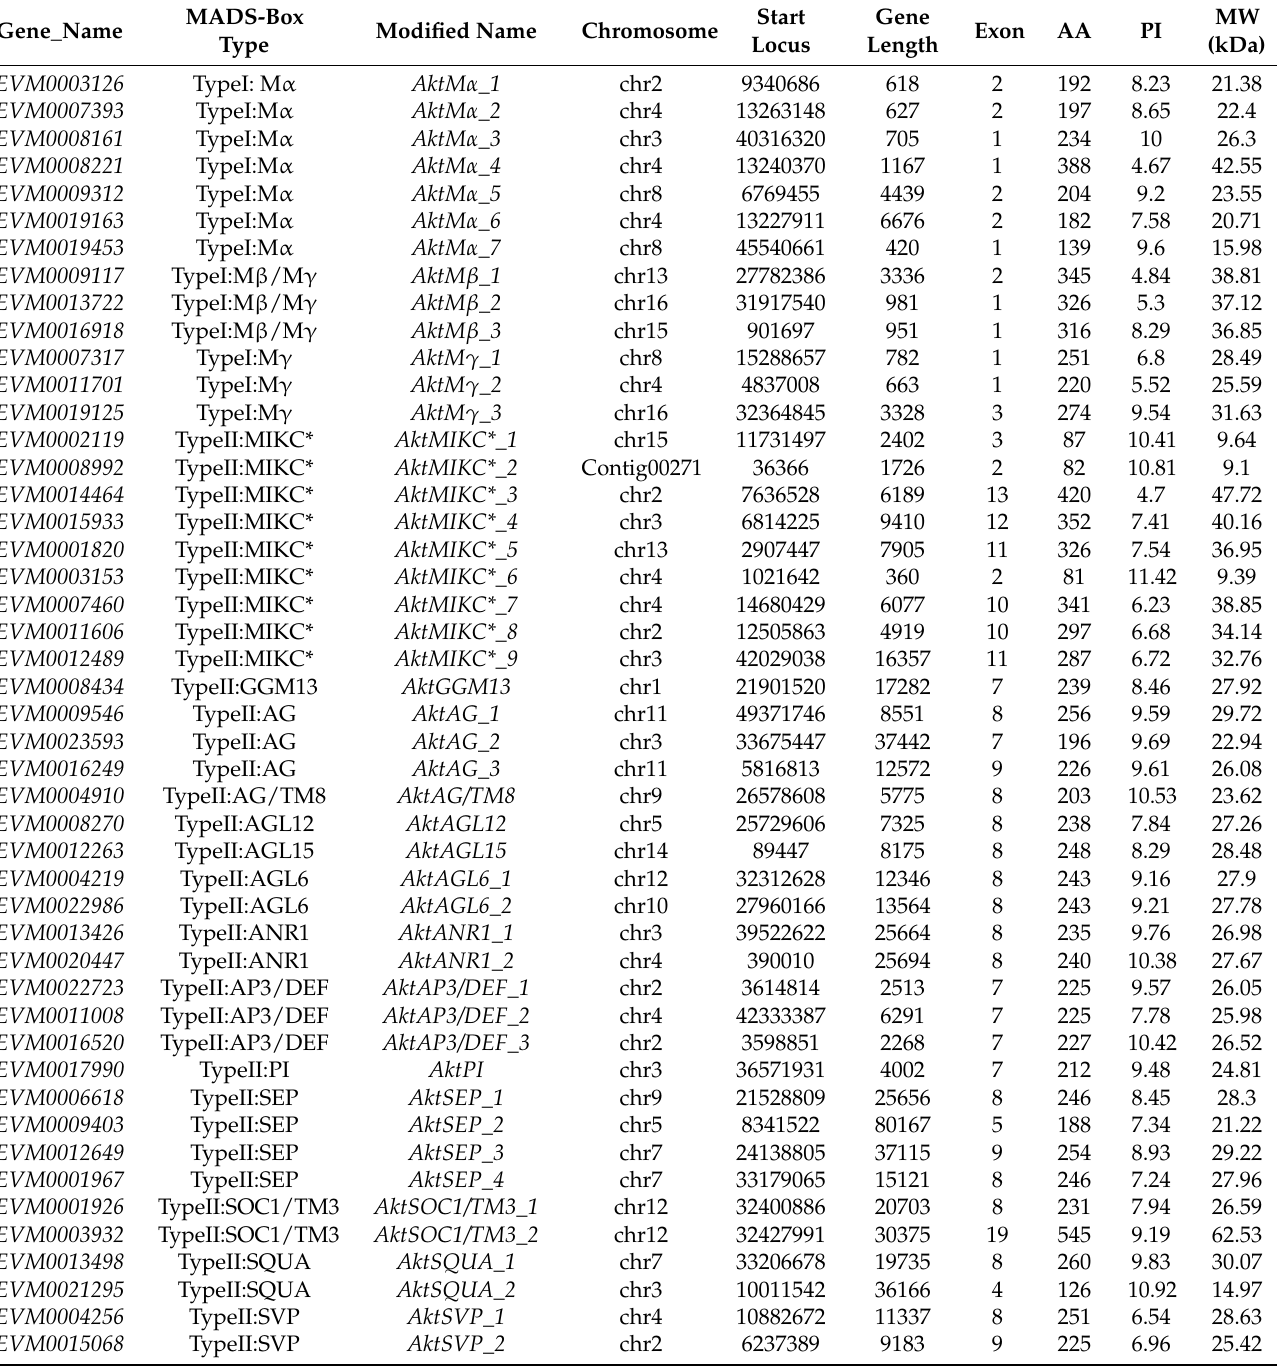
Table 1. Characteristics of the identified MADS-box gene families from the A. trifoliata